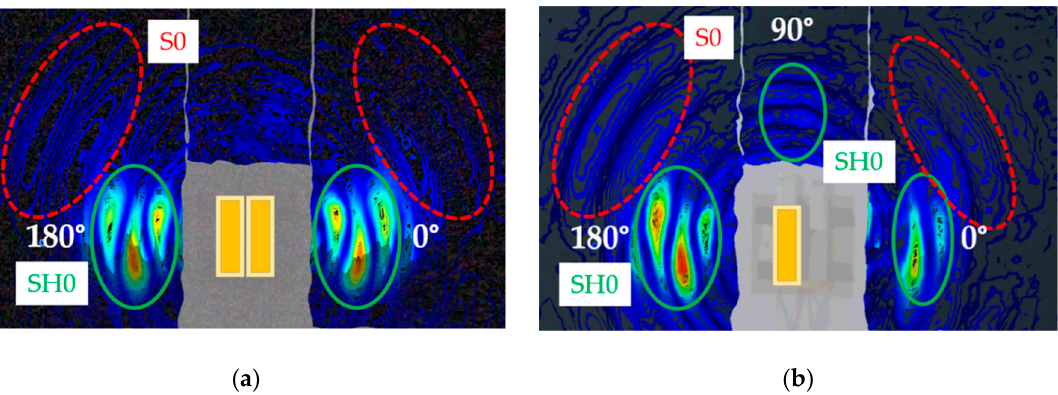
Figure 18. A comparison of measured wave field snapshots between ( a ) the dual SHPFP and ( b ) the original SHPFP at 50.24 µs after excitation. The wave packets in the solid green circles are the SH0 waves, and the ones in the dotted red circles are the unwanted S0 Lamb wave. For the complete videos of the wave propagation, see the section Supplementary Materials at the end of the paper.